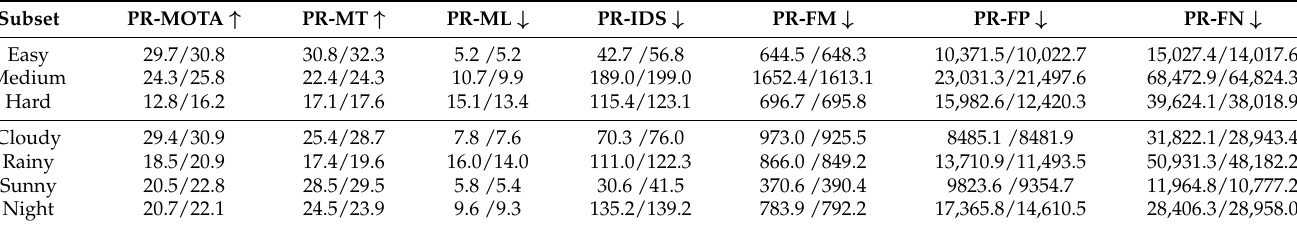
Table 7. MOT results of our single-shot MOT system and FairMOT, which are evaluated on the UA-DETRAC-test subsets.